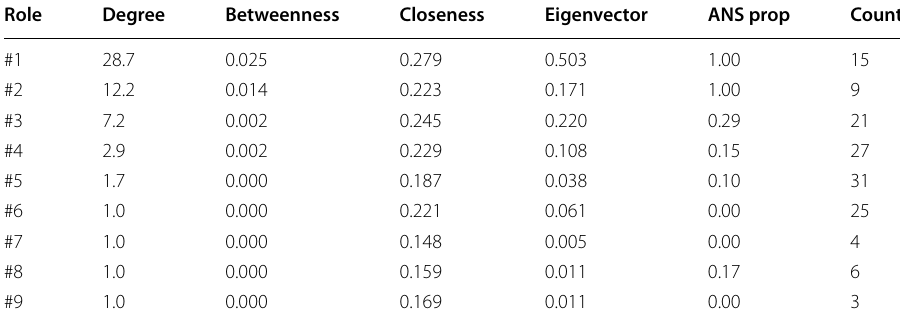
Table 1 Roles identified in Applied Network Science Research and their mean network attributes, including centrality scores, cluster size (count), and the proportion of topics in the cluster identified in ANS research (ANS prop)